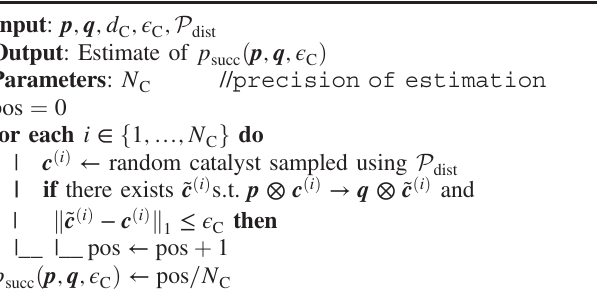
p ; q ; ϵ by sampling. succ ð C Þ